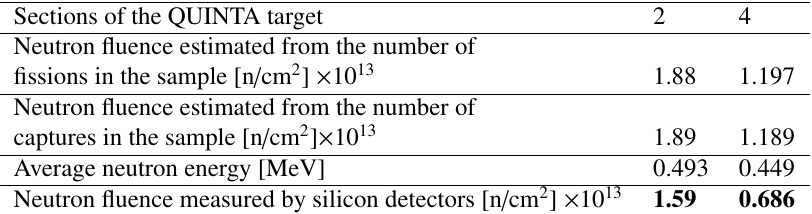
Table 2. Comparison of neutron fluencies measured by two methods for two experiments Sections of the QUINTA